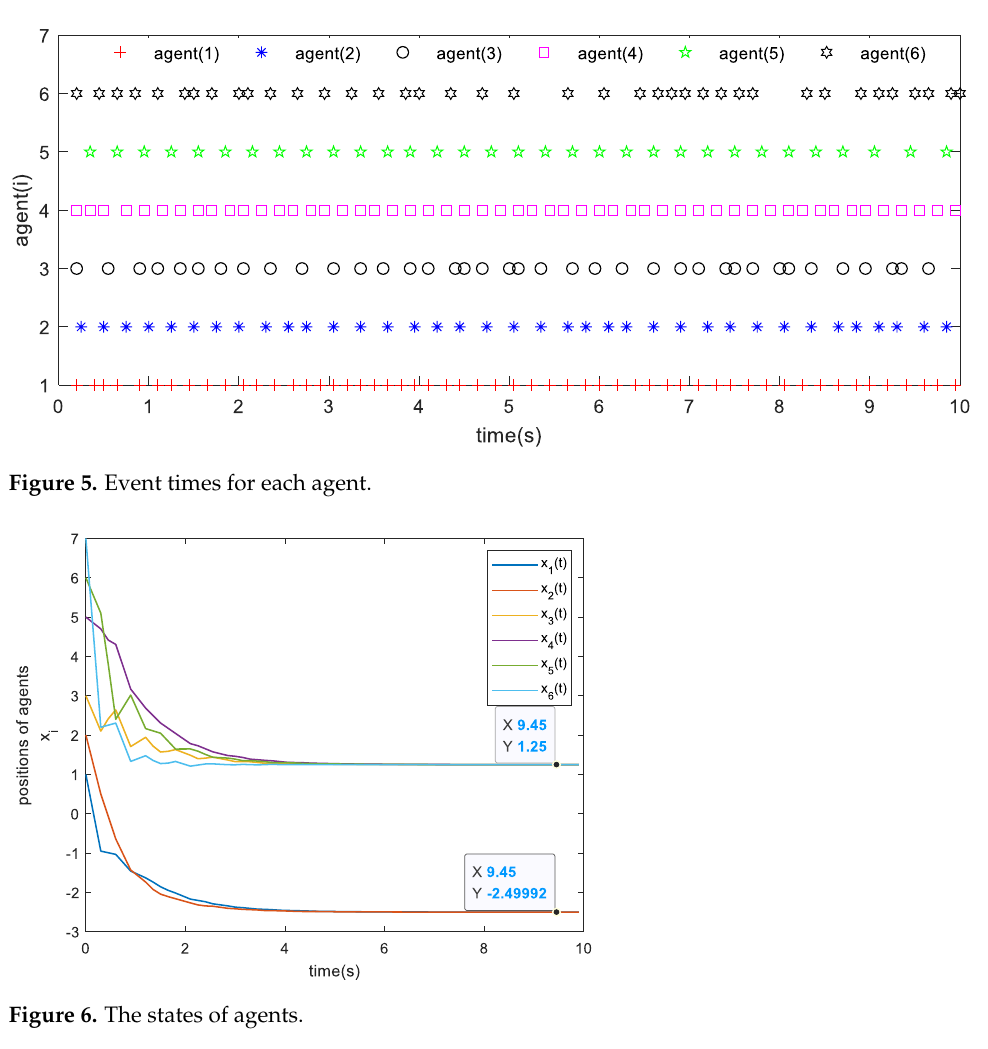
Figure 6. The states of agents.